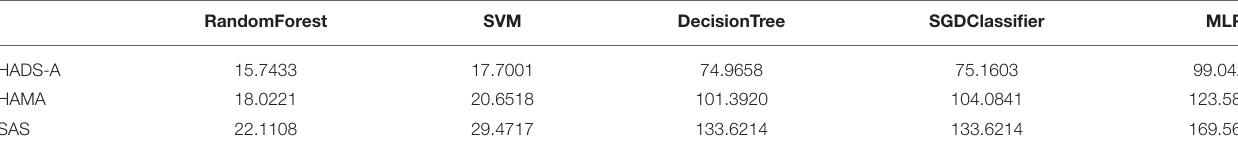
TABLE 7 | Averaging Euclidean distance of 10-fold cross-validation on the five machine learning methods by comparing with Hospital Anxiety and Depression Scale (HADS-A), Hamilton Anxiety Scale (HAMA), and SAS test, respectively. RandomForest